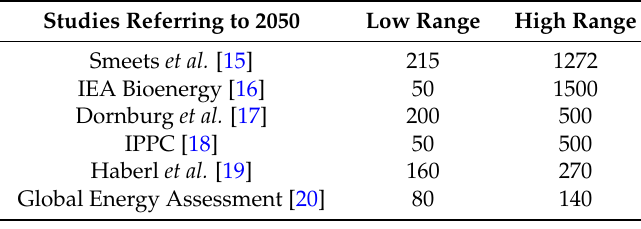
Table 1. Statistical estimates of minimum and maximum values of global bioenergy potential (EJ/year).